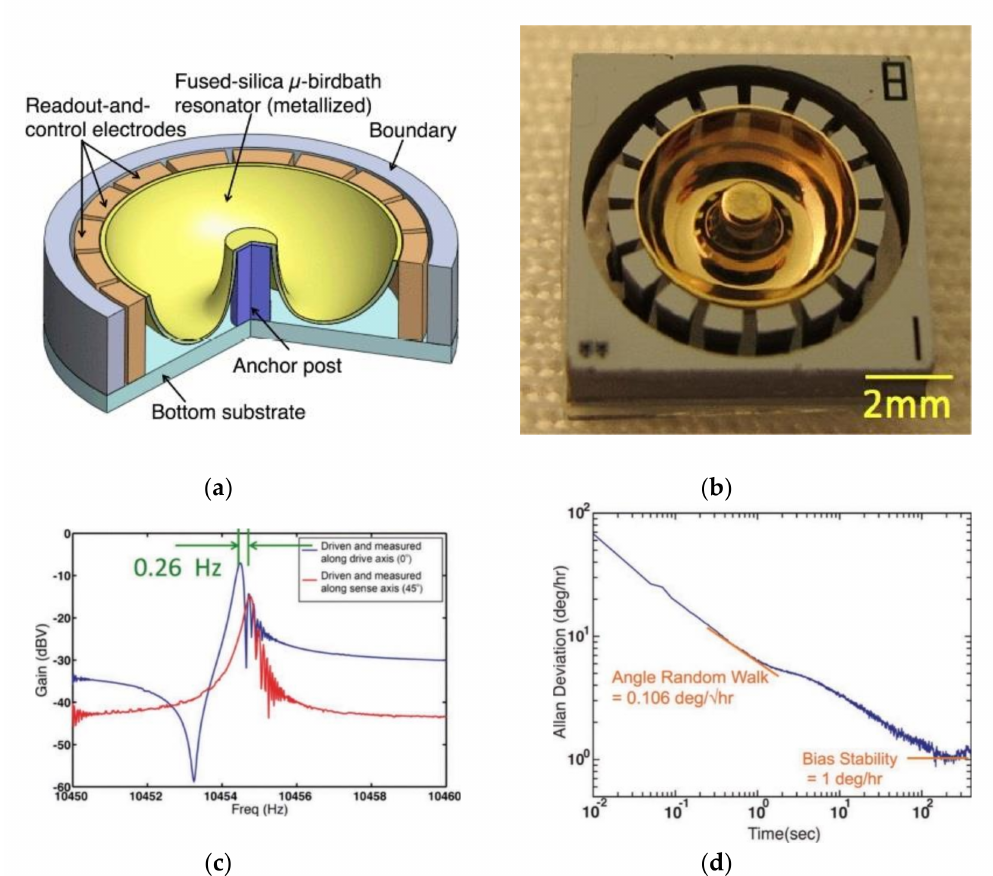
Figure 13. ( a ) Architecture of birdbath gyroscope (Woo et al. [104]), ( b ) final fabrication of BRG (Woo et al. [104]), © 2022 IEEE. Reprinted, with permission from IEEE from J. -K. Woo, J. Y. Cho, C. Boyd and K. NajafI, “Whole-angle-mode micromachined fused-silica birdbath resonator gyro- scope (WA-BRG)”, in MEMS 2014, San Francisco, CA, USA, January 2014 ( c ) Frequency response (Cho et al. [69]), ( d ) Allan deviation plot (Cho et al. [69]) © 2022 IEEE. Reprinted, with permission from IEEE from J. Y. Cho, J. K. Woo, R. L. Peterson and K. Najafi, “Fused-Silica Micro Birdbath Resonator Gyroscope ( µ -BRG)”, Journal of Microelectromechanical Systems, vol. 23, no. 1, pp. 66–77, February